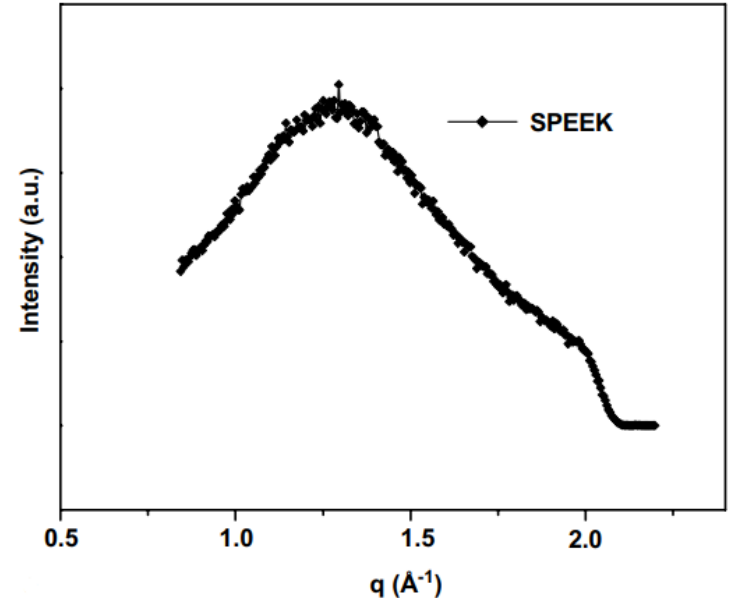
Figure 19. WAXS analysis revealed an amorphous structure of SPEEK due to the broad